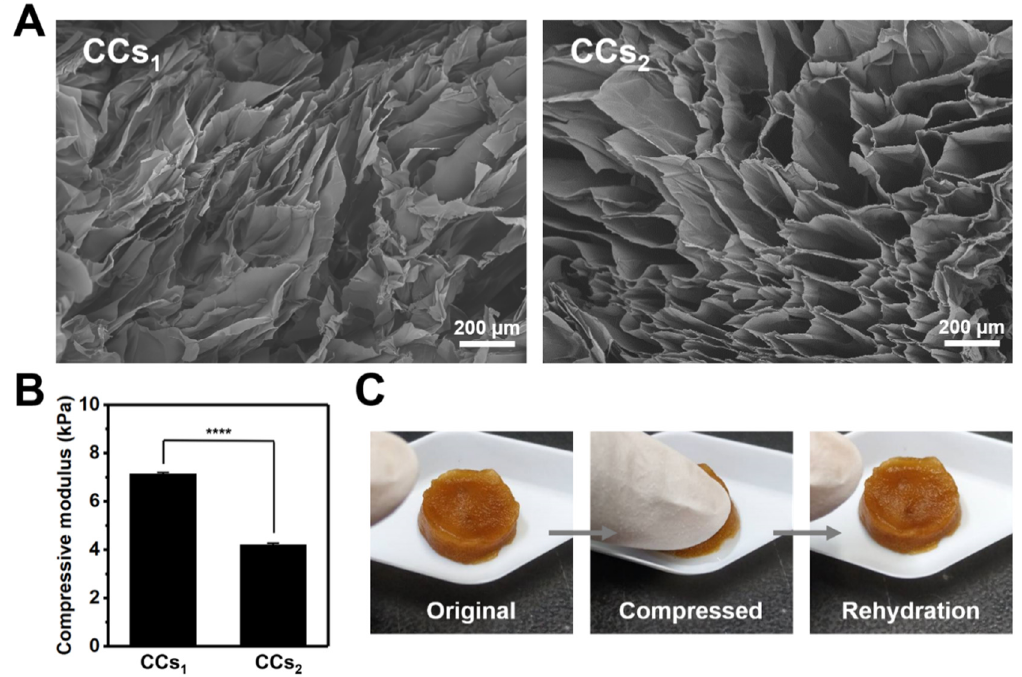
Figure 9. Properties of CCs 1 (the lyophilized CC 1.5 hydrogel) and CCs 2 (the lyophilized CC 2.0 hydrogel) scaffolds. ( A ) SEM images of the CCs 1 and CCs 2 scaffolds. ( B ) The compressive modulus of rehydrated CC scaffolds measured at a 1% compressive strain and 1 Hz frequency. **** represents p < 0.0001. ( C ) The macroscopic behavior of the CCs 2 scaffold showing high compressibility.